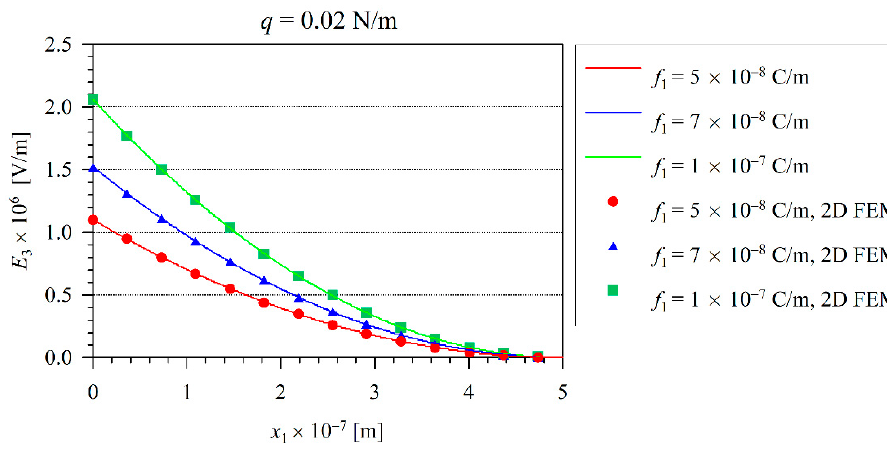
Figure 3. The distribution of the electric field 3 E along